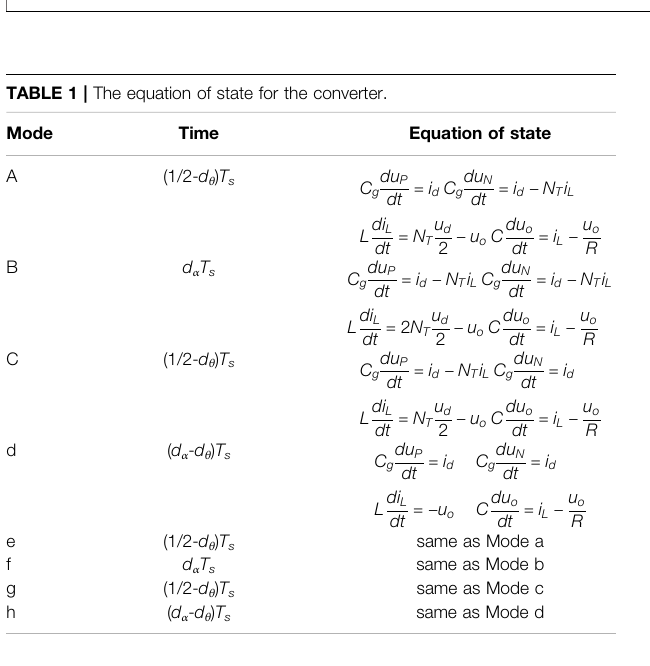
FIGURE 5 | Simpli fi ed circuit of the three-level H-bridge DC/DC converter. (A) Left half equivalent circuit (B) Right half equivalent circuit.